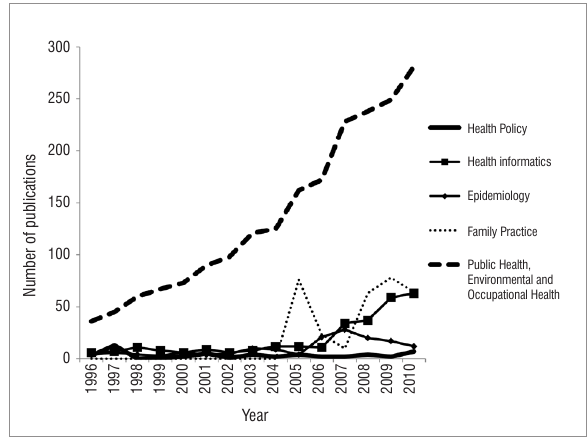
Figure 6: Number of publications from South Africa in Health Policy, Epidemiology and Public Health disciplines during 1996–2010.